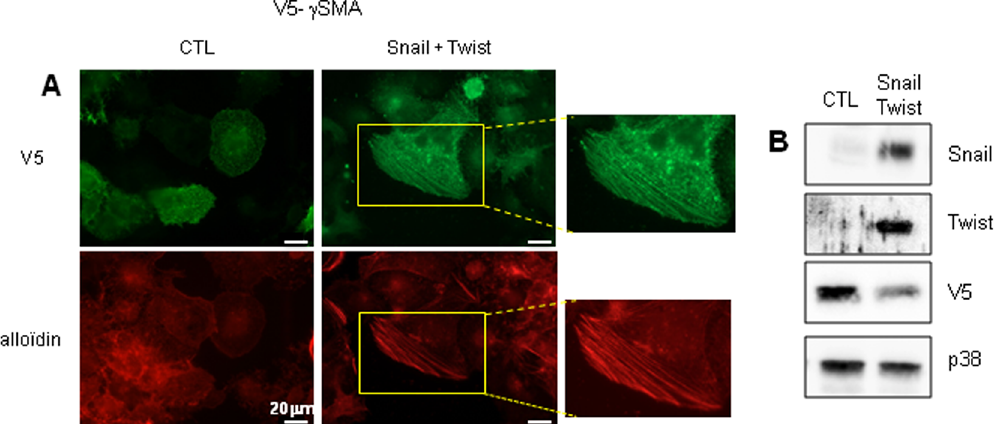
Fig 2. Snail and Twist expression induced γ SMA polymerization. (A) HuH7 cells were transfected with a V5-tagged vector coding for γ SMA alone (CTL) or together with vectors coding for Snail and Twist. The expression of V5 was determined by immunofluorescence analysis. Actin polymerization was revealed by Phalloidin staining. (B) The expression of V5, γ SMA, Snail and Twist was analysed by Western blotting. p38 was used as a control